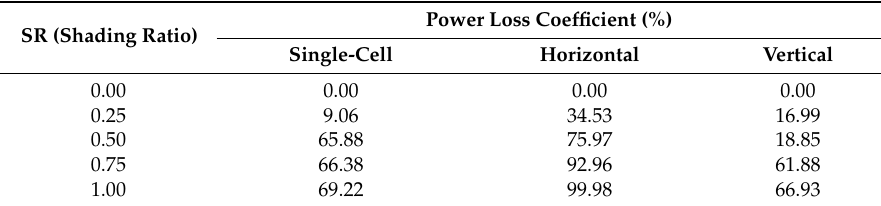
Table 1. Power loss coefficient values of shading ratio.